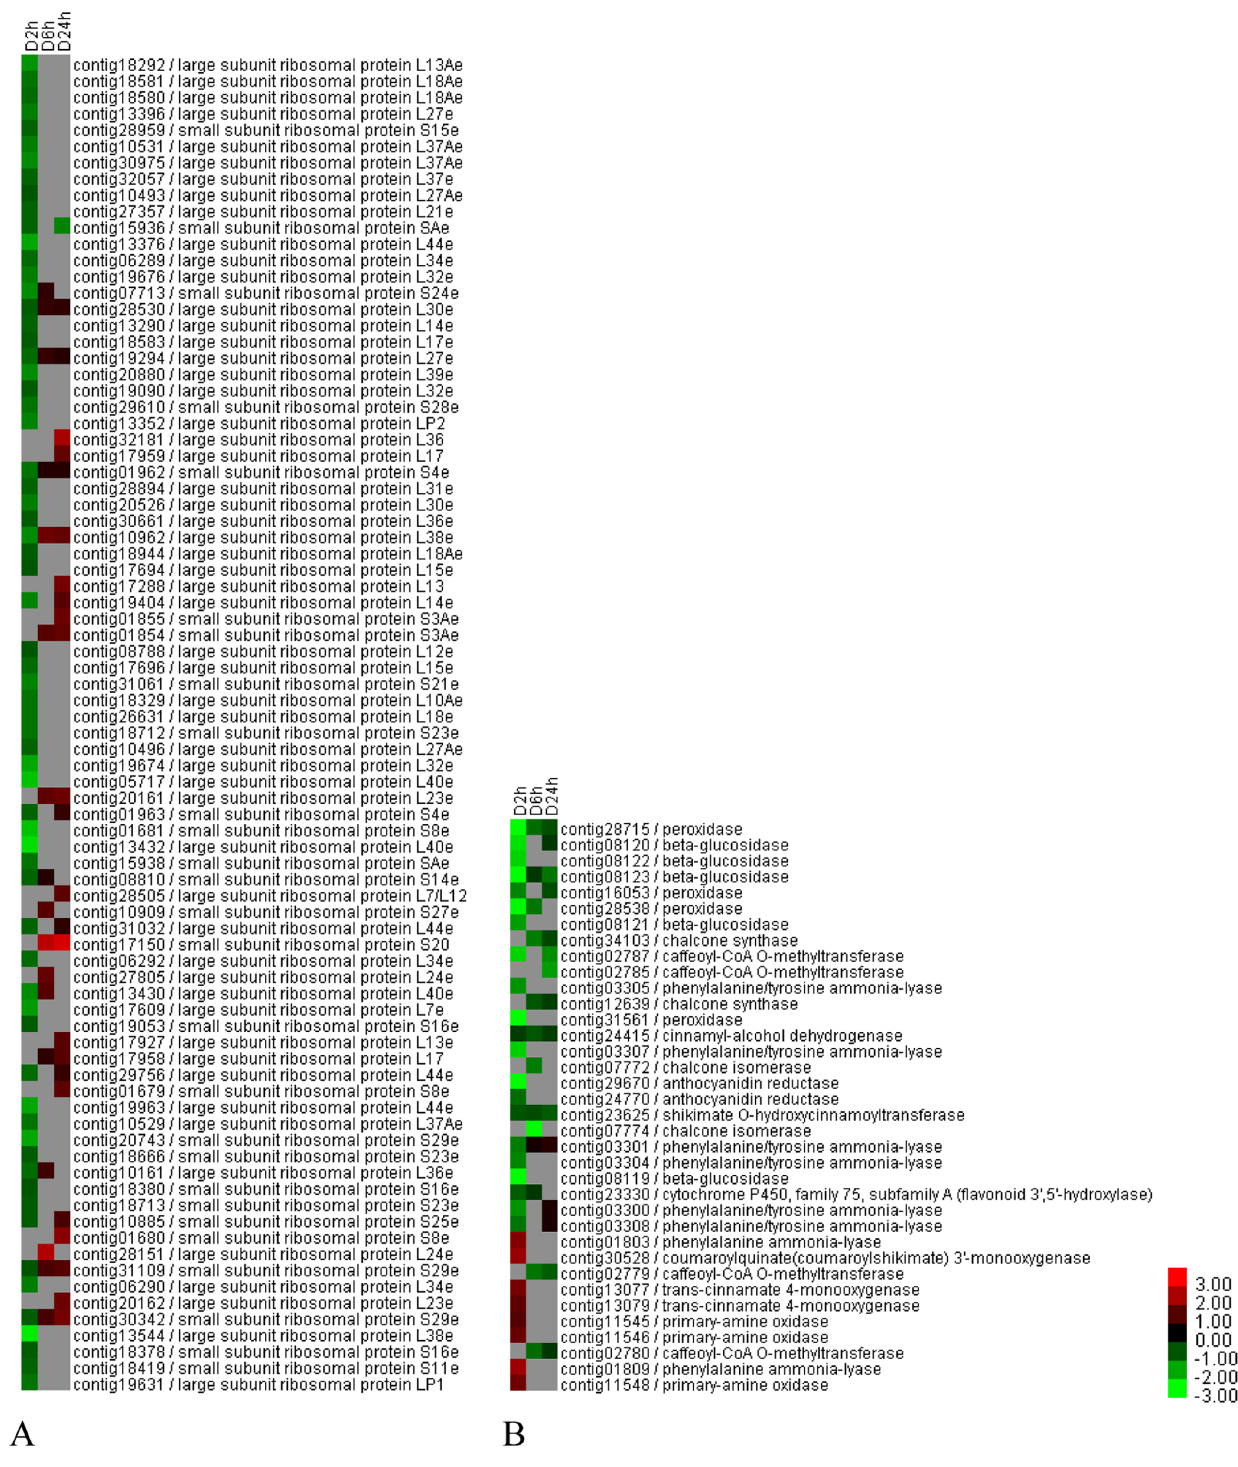
Figure 4. Expression levels of defoliation-responsive DEGs specifically enriched in KEGG pathways. (A) Ribosomal DEGs. (B) DEGs involved in phenylpropanoid biosynthesis; flavonoid biosynthesis; stilbenoid, diarylheptanoid and gingerol biosynthesis; and phenylalanine metabolism. Green to bright red: down-regulation to up-regulation. D, defoliation. doi:10.1371/journal.pone.0089495.g004 leading to the formation of hydroperoxy octadecadienoic acids, allene oxide synthase (AOS) and subsequently by allene oxide which are then converted into 12-oxo phytodienoic acid (12- cyclase (AOC). OPDA is then converted to JA by 12-oxo- OPDA) in the plastids via enzymatic reactions catalyzed first by phytodienoic acid reductase (OPR) followed by three cycles of b -